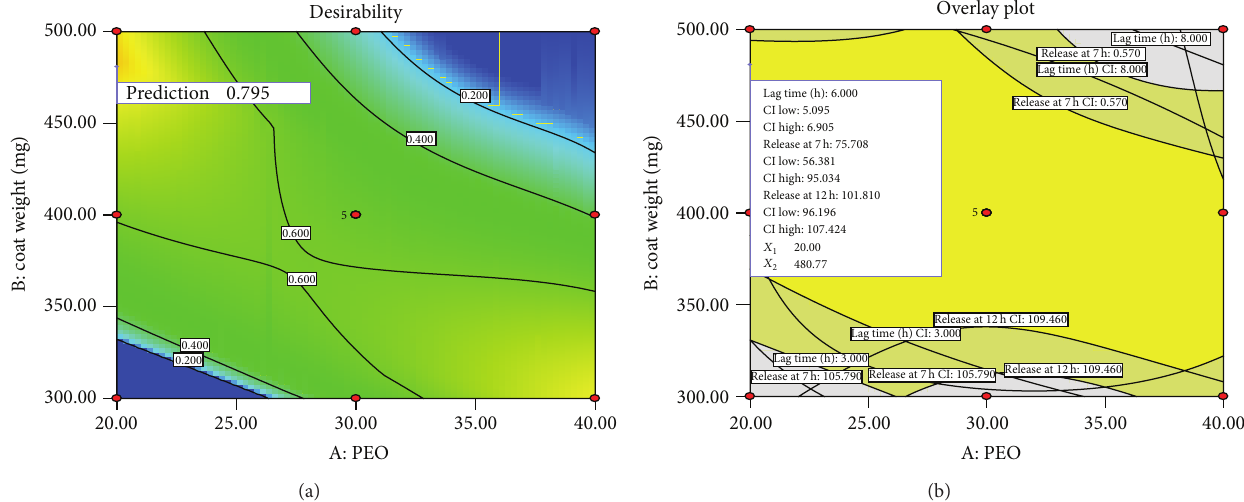
Figure 7: Desirability and overlay plots for optimization of floating pulsatile release tablets of lercanidipine HCl with PEO % and coat weight (mg). Table 6: Comparison of predicted and observed responses for the statistically optimized formulation FP 14.